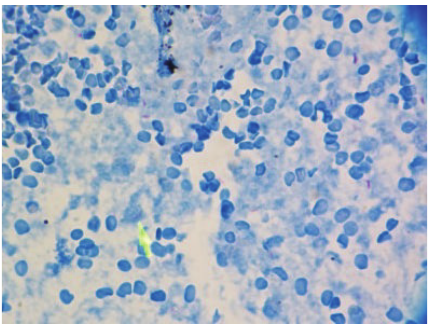
Figure 2: Acid-fast stain showing AFB positive bacteria (small red bacilli). Magnification